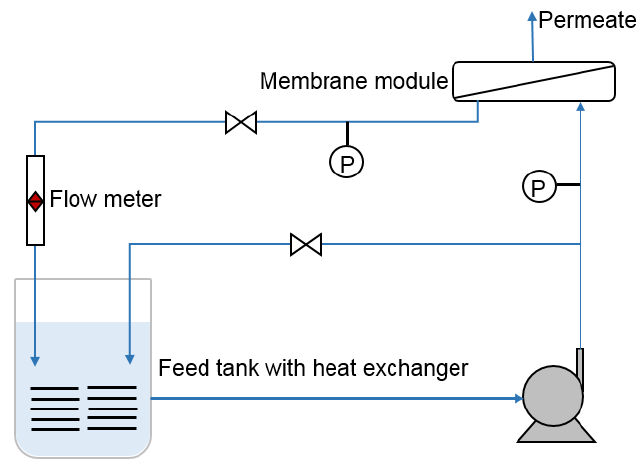
Figure 2. Schematic diagram of the experimental apparatus used to evaluate the permselectivity of the fabricated RO membranes.